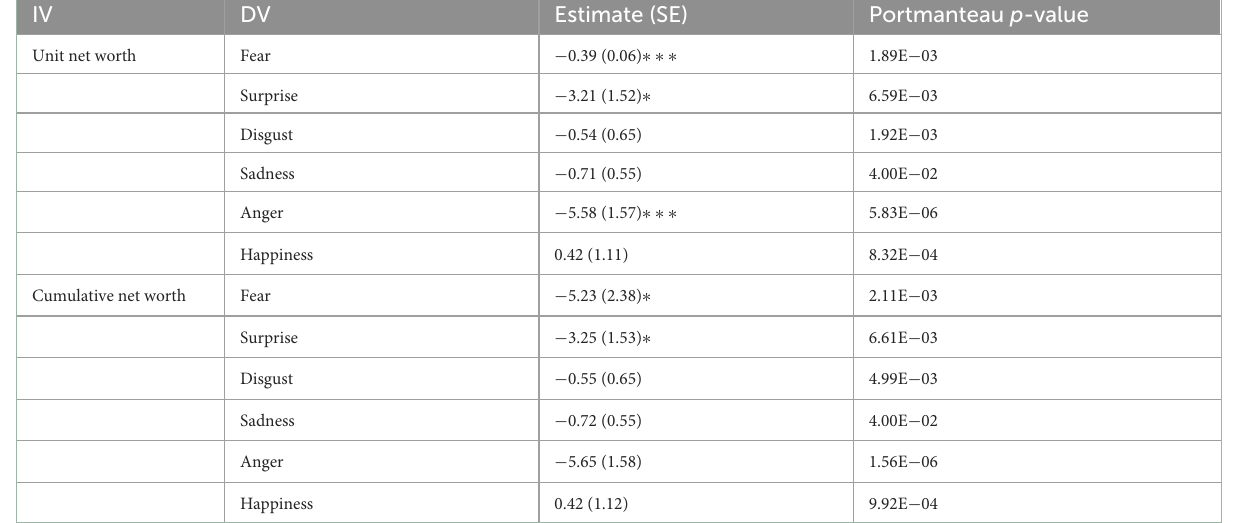
TABLE 6 Vector auto-regressive model ( p = 1) between emotions and fund performance of the Lombarda China Healthcare Mix Fund. IV DV Estimate (SE) Portmanteau p -value Unit net worth